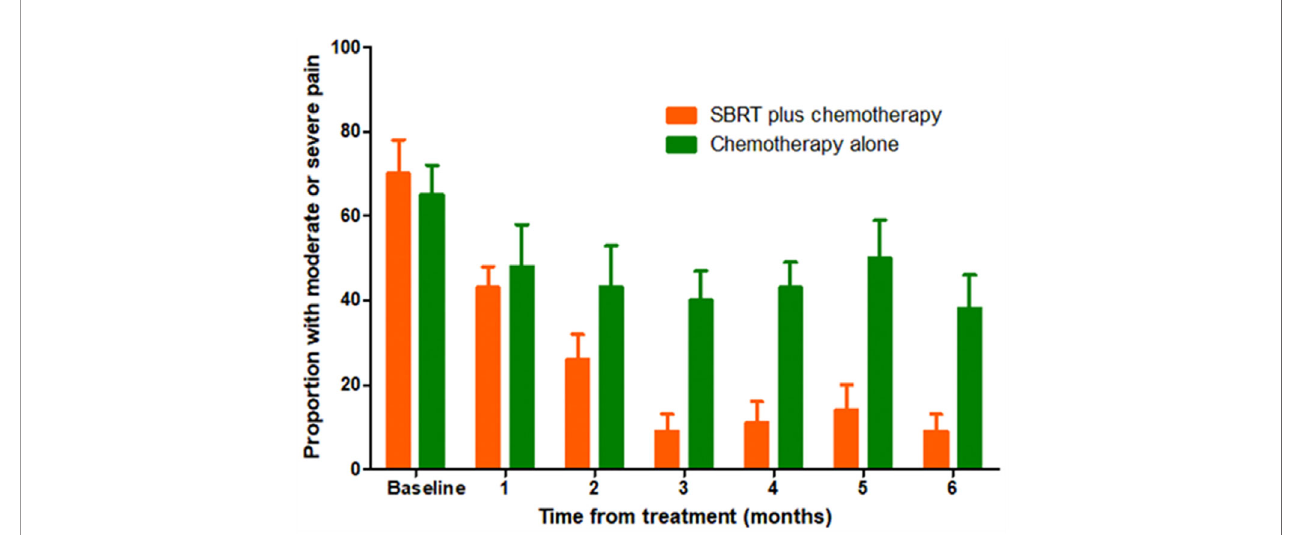
FIGURE 4 | Proportion of patients with moderate or severe abdominal/back pain over time in the matched